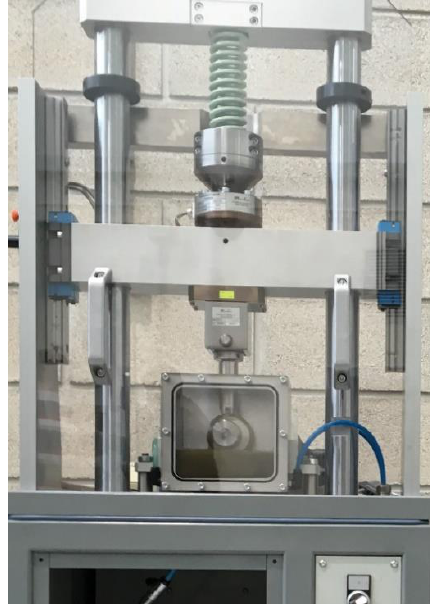
Figure 3. Equipment for testing the in-service wear behaviour of mechanical parts.